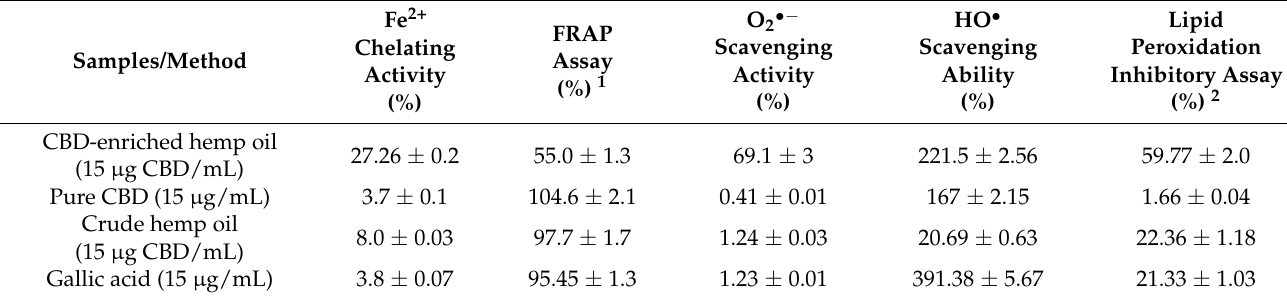
Table 3. Antioxidant activity of CBD-enriched hemp oil, pure CBD, crude hemp oil and gallic acid. Samples/Method